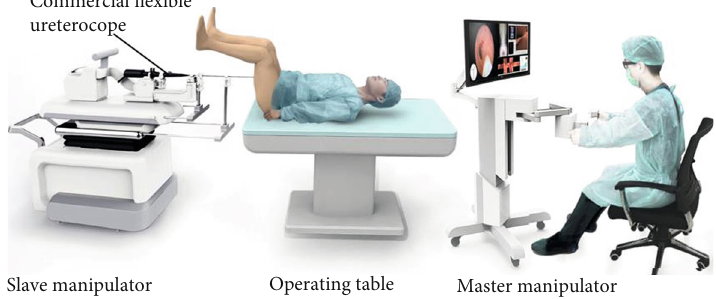
Figure 3: The conceptual design of the robot-assisted system for FURS in a master-slave con fi